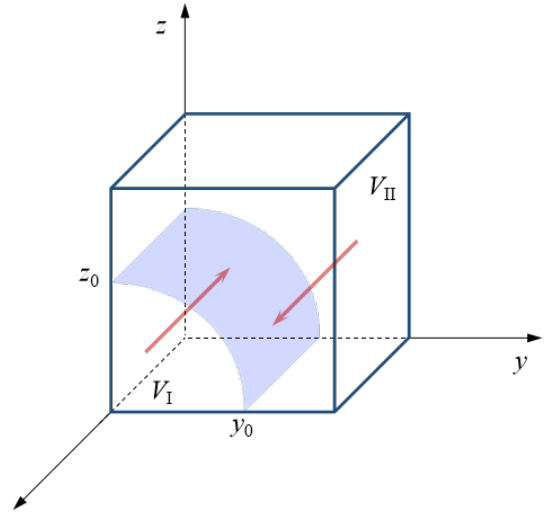
Figure 2. Evolutionary phase diagram of the local government ’s strategy.